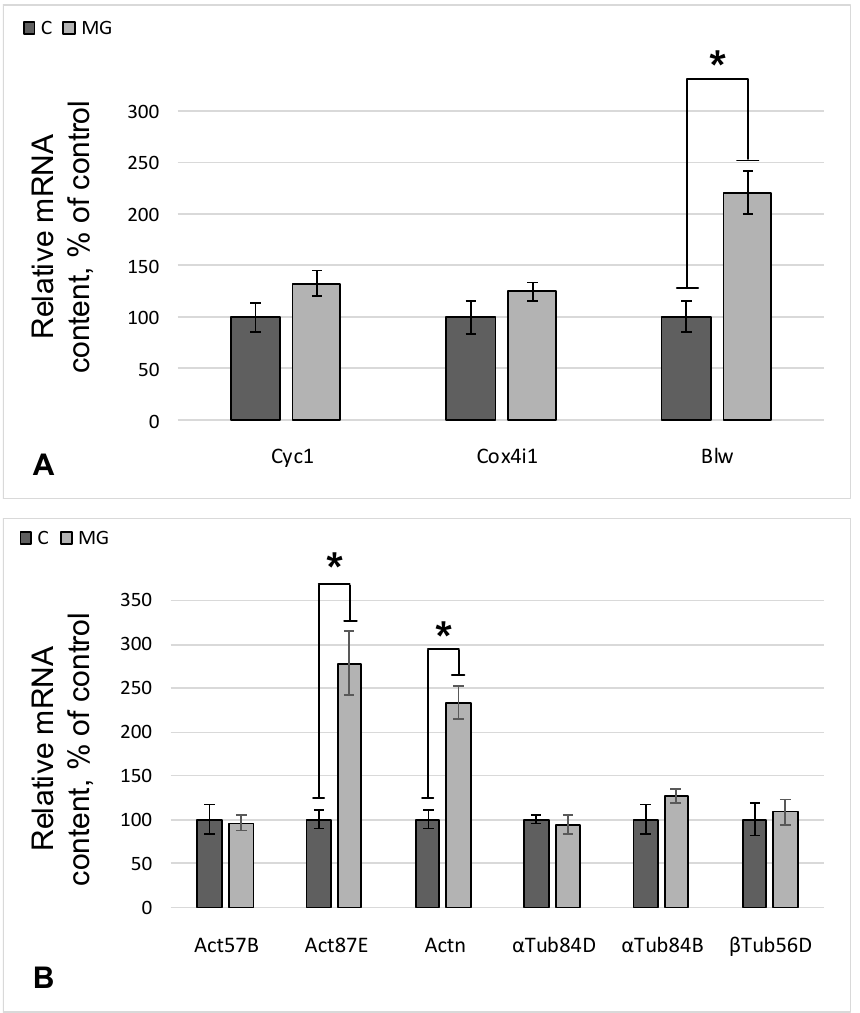
Figure 3. The relative content of mRNA. ( A ) mRNA of genes encoding proteins involved in the cellular respiration of mitochondria. Cyc1—mRNA of the gene encoding cytochrome c; Cox4i1—mRNA of the gene encoding cytochrome c oxidase; Blw—mRNA of the gene encoding the subunit of ATP synthase F1. ( B ) mRNA of genes that form the structures of the actin and tubulin cytoskeleton. Act57B and Act87E—mRNA of genes encoding beta-actin; Actn—mRNA of the gene encoding alpha-actinin; α Tub84D and α Tub84B—mRNA of genes encoding alpha-tubulin; β Tub56D—mRNA of the gene encoding beta-tubulin; C—control group; MG—group of simulated microgravity. * p < 0.05 compared to control group C.